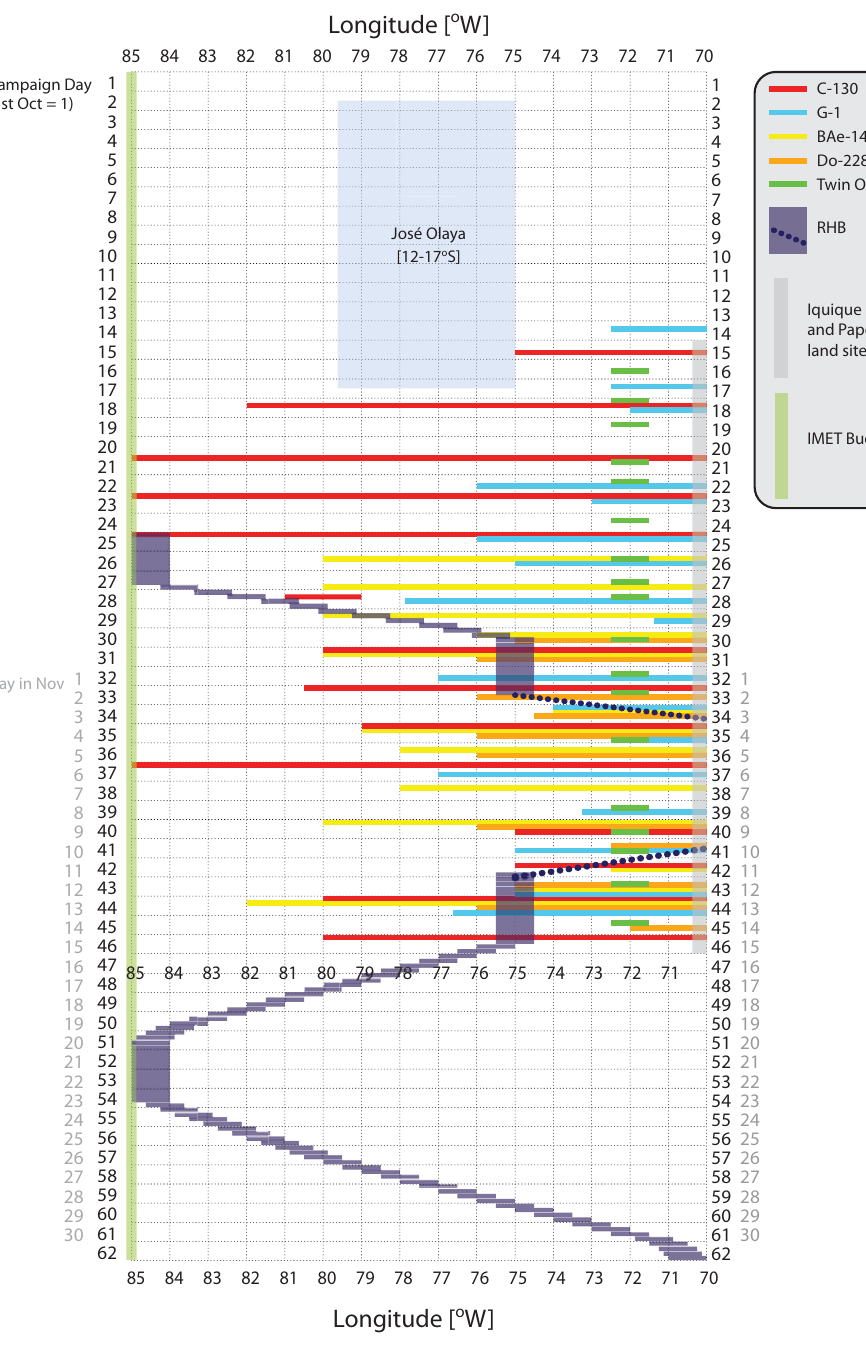
Fig. 3. Operations summary showing platform longitude against time during VOCALS-REx.